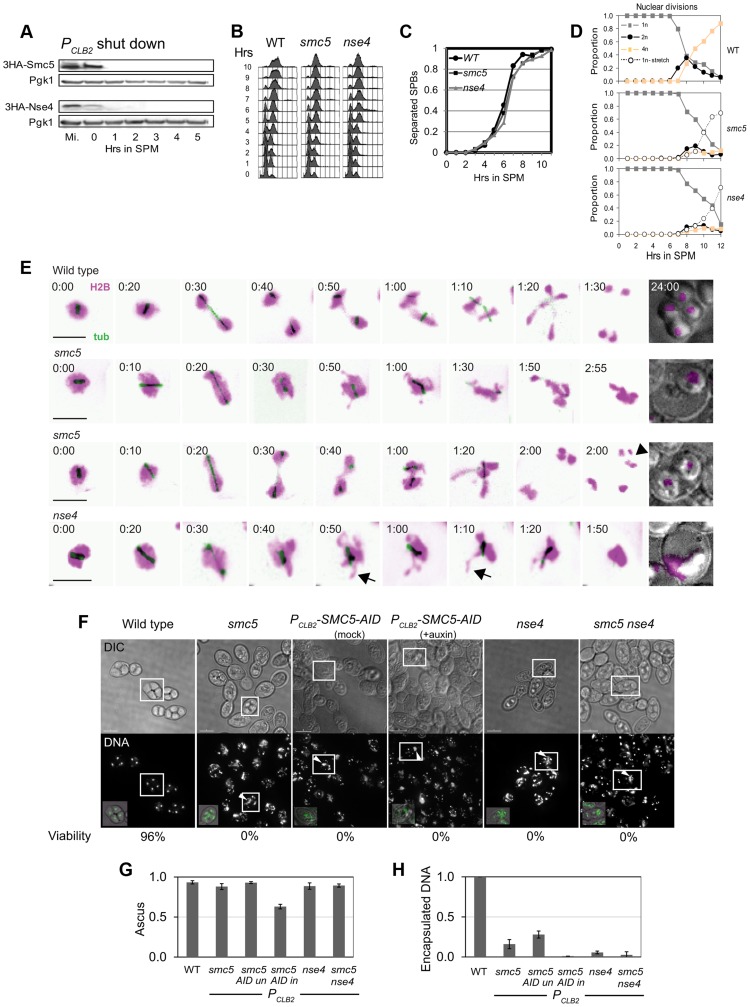
Meiotic depletion of Smc5 or Nse4 leads to meiotic catastrophe.(A) Western blot of depletion of 3HA-Smc5 (Y941) and 3HA-Nse4 (Y942) protein levels under the PCLB2 promoter. Mutants are referred to as smc5 and nse4 throughout. (B) FACS analysis of S-phase progression in wild type (Y940), smc5 (Y941) and nse4 (Y942) mutants. (C) Population kinetics of spindle pole body separation (n = 200 per time point). (D) Population kinetics of nuclear divisions (n = 200 per time point). (E) Montage of time series of nuclear divisions and spindle dynamics from representative time-lapse movies. H2B-mCherry and Tub1-GFP are pseudo-coloured in magenta and green, respectively. Maximum projections are shown. Bars: 4 µm. Full movies are available as Supplemental Movies S1 to S4. Arrows indicate examples of nuclear spikes and arrowheads show fragmentation/micronuclei. Strains: WT (Y3606), smc5 (Y3627), nse4 (Y3630). (F) DNA encapsulation failure in smc5 and nse4 mutants. Upper panel DIC, lower panel, DAPI (DNA). The boxed asci are shown with DNA (green) overlaid in the insets in the lower panel, bottom left. Note that the samples are taken from different time points in the various strains. Bars, 5 µm. (G) Proportion of cells completing meiosis and forming an ascus (di-tyrosine fluorescence). (H) Proportion of asci with encapsulated DNA (bottom). All data were collected after 24 hours in liquid sporulation medium. Three independent diploids were assessed for each genotype (standard deviations are shown). Strains: WT (Y1381), smc5 (Y2705), PCLB2-SMC5-AID (Y3252), nse4 (Y2704), smc5 nse4 (Y3185).